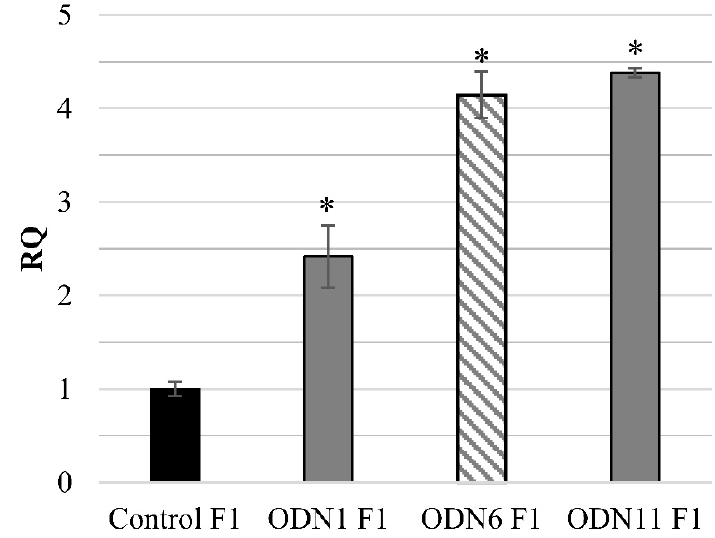
Figure 1. CHS gene expression in the F1 generation of plants that maintained modifications induced by short oligodeoxynucleotides (ODNs), cultivated in the experimental field. The seeds obtained from F0 plants were sown and plants were cultivated in the field. The total expression of both CHS genes, LuCHS6 and LuCHS7 , was determined by the real-time PCR reaction. The values are referred to the reference gene expression actin. The relative quantity (RQ) presents the transcript level in comparison to the control (set as 1, black). Plants treated with ODN6 met did not maintain in the F1 generation the initially observed level of CHS gene expression (bar presented in diagonal stripes). Data represent the mean value ± SD from at least three repeats of the experiment. The significance of the differences between each mean and control was determined by Student’s t -test. Asterisk indicates * p < 0.05.